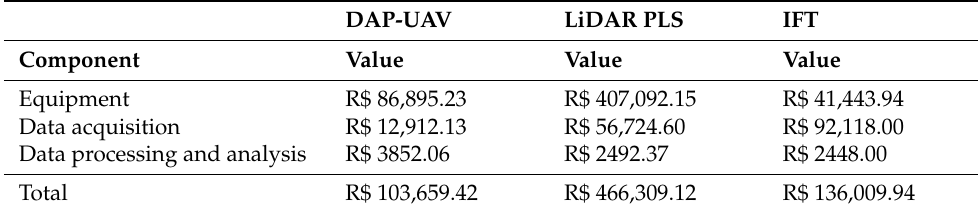
Table 14. Costs to obtain data by DAP-UAV, LiDAR PLS, and TFI .